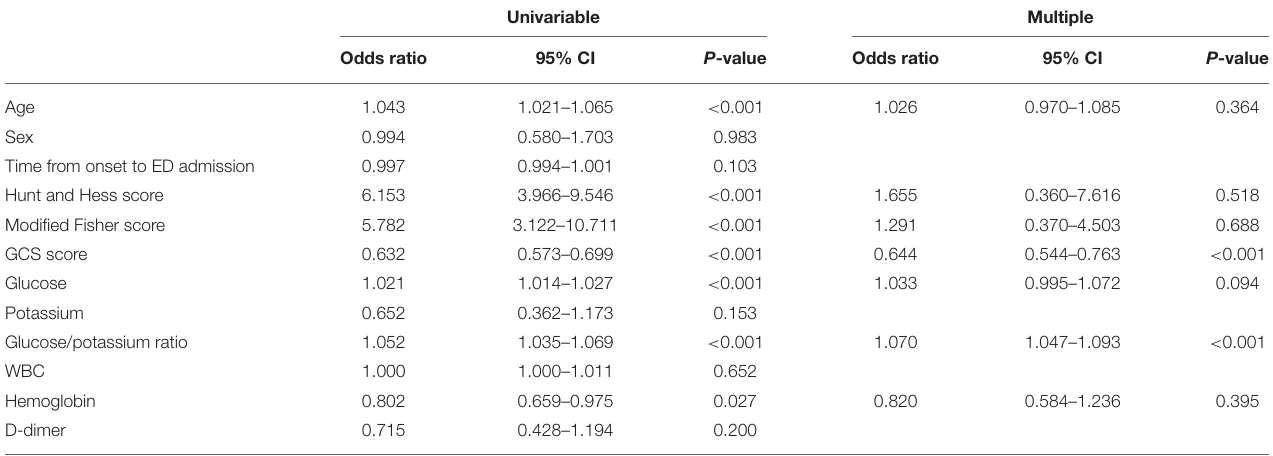
TABLE 4 | Variables associated with 3-month mortality identified by logistic regression